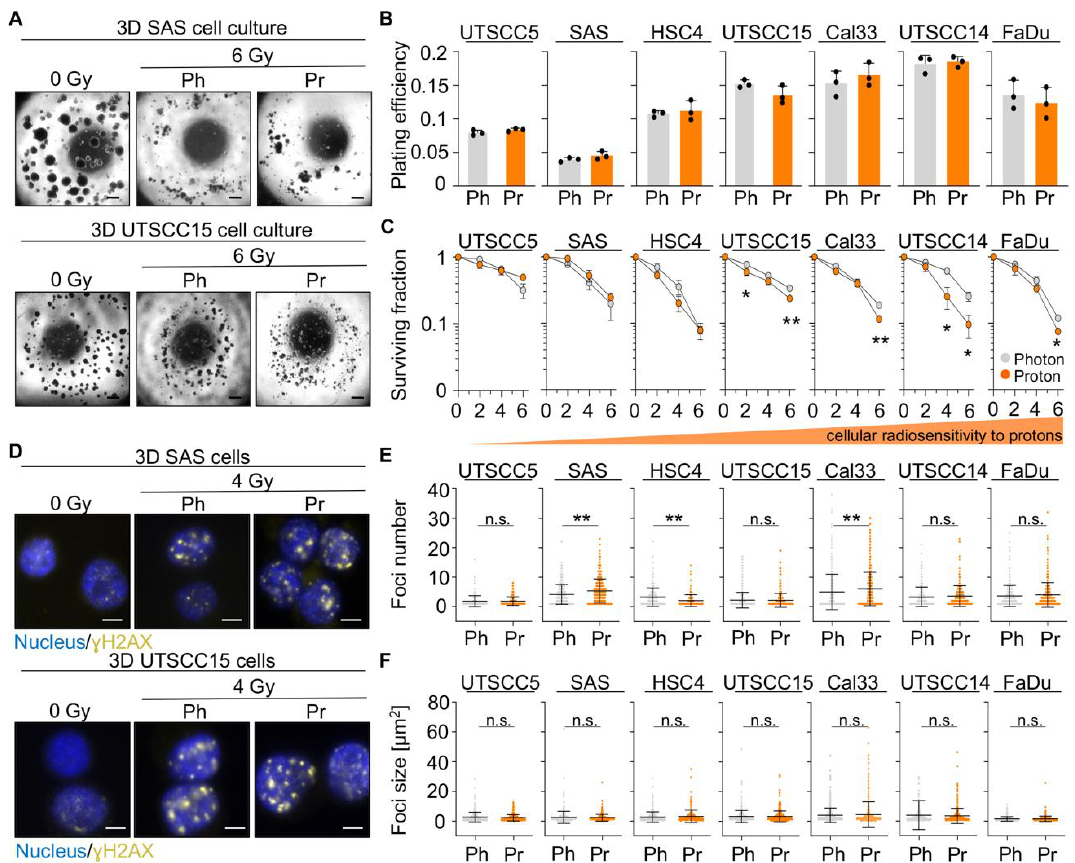
Figure 1. The intrinsic cellular radiosensitivity to photon and proton irradiation varies among 3D lrECM grown HNSCC cell cultures. ( A ) Representative microscopy images of unirradiated and irradiated 3D lrECM SAS and UTSCC15 cell colonies. Scale bar, 200 µ m. ( B ) Plating efficiencies of unirradiated 3D lrECM HNSCC cell cultures. ( C ) Clonogenic radiation survival of indicated HNSCC cell lines upon photon or proton irradiation. ( D ) Representative immunofluorescence images of residual γ H2AX foci at 24 h post 4-Gy irradiation (Scale bar, 20 µ m; γ H2AX in yellow and nuclei in blue). ( E ) Dot plots of residual foci numbers and ( F ) foci sizes 24 h post photon or proton exposure (4 Gy). At least 100 cells were analyzed per biological replicate. Results show mean ± SD ( n = 3; two-sided t -test; * p < 0.05, ** p < 0.01). Ph, photon irradiation; Pr, proton irradiation; n.s.,